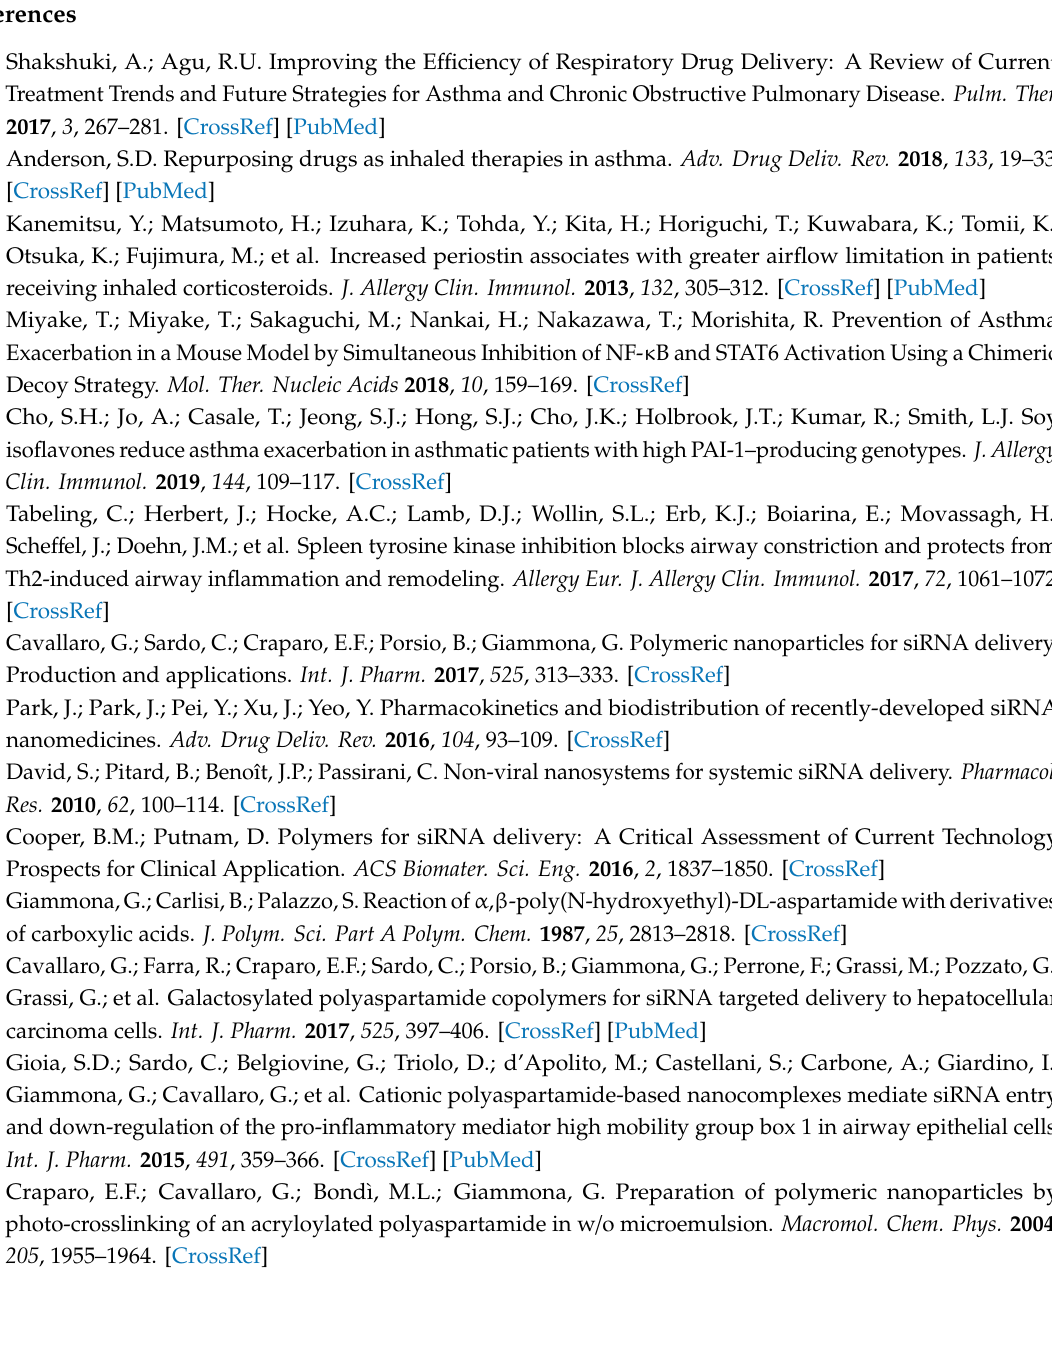
Figure S1: SEC chromatograms of: a) PHEA-g-bAPAE (black), PHEA-g-PEG(A)-g-bAPAE (blue), PHEA-g-PEG(B)-g-bAPAE (red), PHEA-g-PEG(c)-g-bAPAE (green); b) PHEA-g-PEG(A) (black), PHEA-g-PEG(B) (red), PHEA-g-PEG(C)